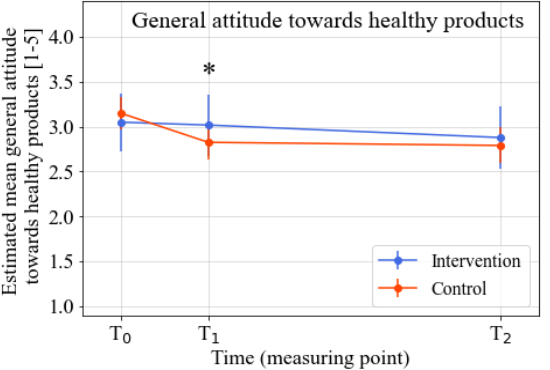
Figure 5. Estimated marginal means of general attitude towards healthy products from T0–T2. Note. Time span: T1–T0 = three weeks; T2–T0 = three months. * Significant difference between the inter- vention and control group ( p ≤ 0.05). Analyzed by linear mixed model analyses. All analyses were corrected for baseline outcome, sex, age, FV product assessed in the questionnaire, and the baseline scores of the other four determinants of FV intake.